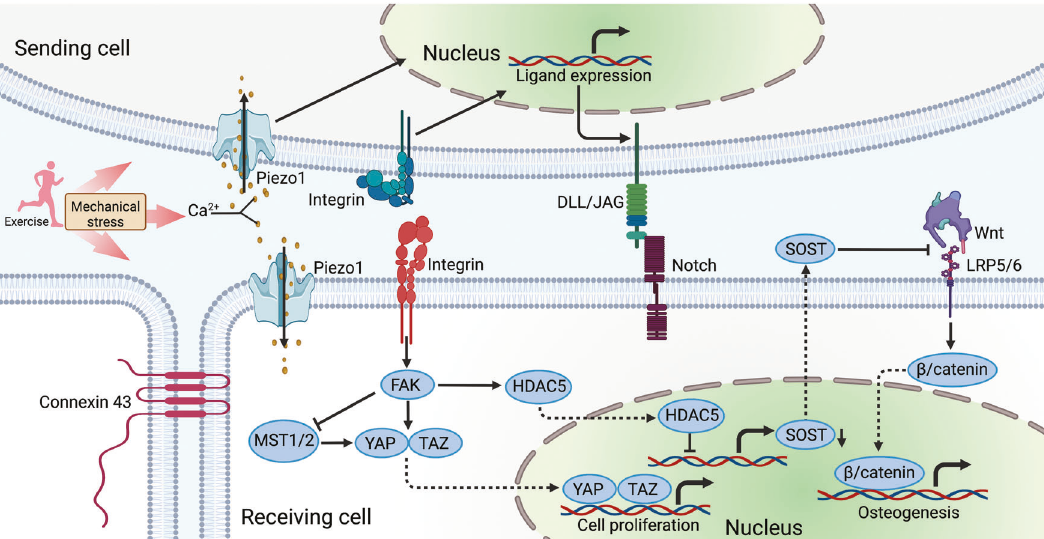
Fig. 2 Mechanotransduction regulating regenerative responses. The signaling transduction of exercise-induced regeneration are generally initiated by mechanical signals. A series of membrane receptors or channels can respond to mechanical signals, thereby converting mechanical signals into chemical molecular signals. Piezo1 channels, working as non-selective cationic channels, sense the exercise-induced stress, converting into mechanical stress-evoked Ca 2 + signaling. Integrin-based adhesion complex activates FAK, promoting YAP/TAZ translocation via inhibiting Hippo signaling. FAK can drive HDAC5 nuclear translocation and suppress SOST. Integrins or Piezo channels activate the transcription of ligands of Notch receptor in sending cell, triggering Notch signaling of receiving cell. Wnt/ β -catenin pathway is important in osteogenesis, which can be inhibited by SOST. Connexin 43 responds to the mechanotransduction for cell-to-cell communication. Created with